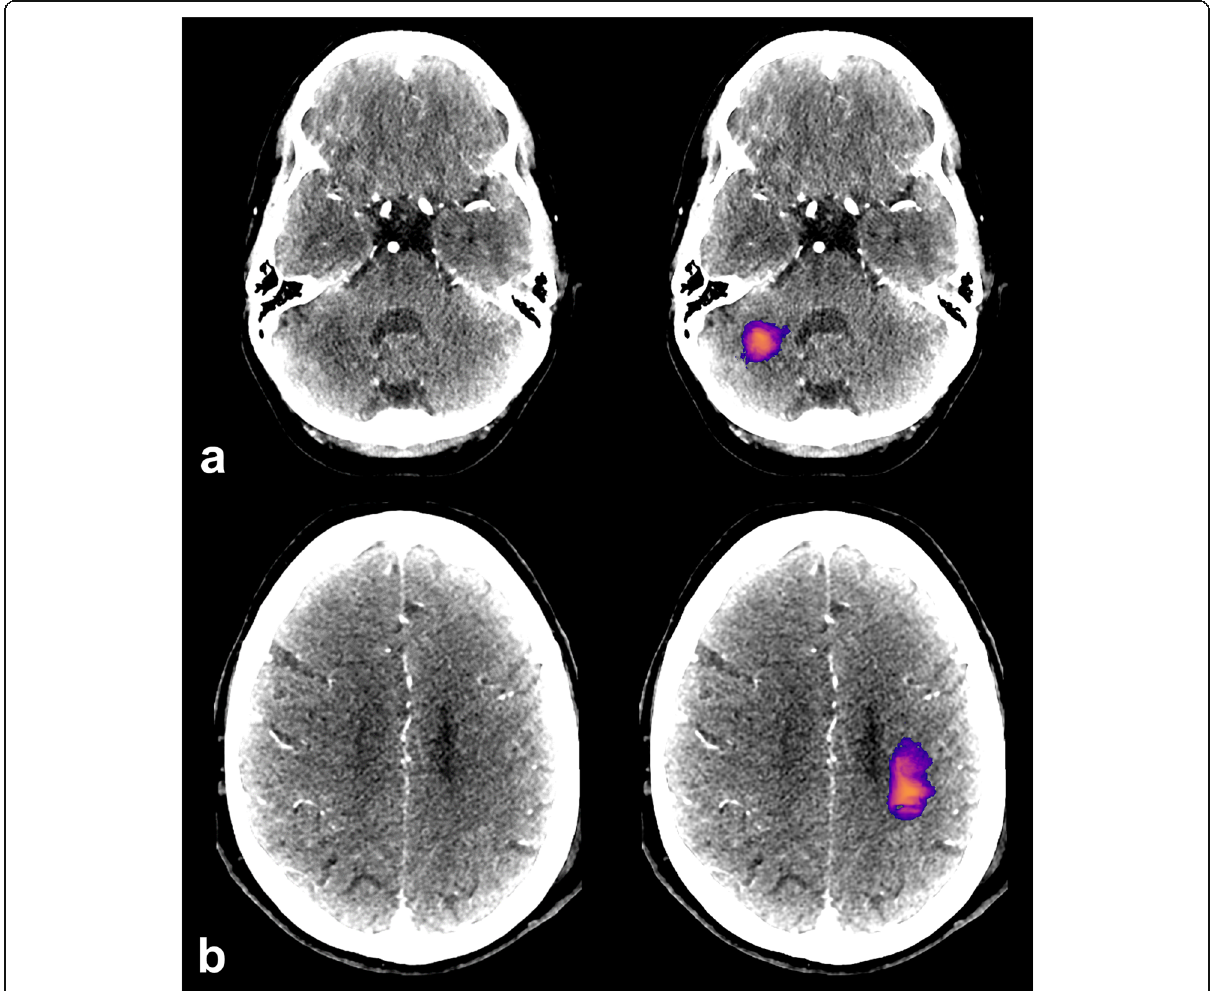
Fig. 8 Representative cases of false positive lesions. A lesion caused by beam hardening artefact in the posterior fossa ( a ). A false positive lesion for which no clear radiologic correlation could be found ( b